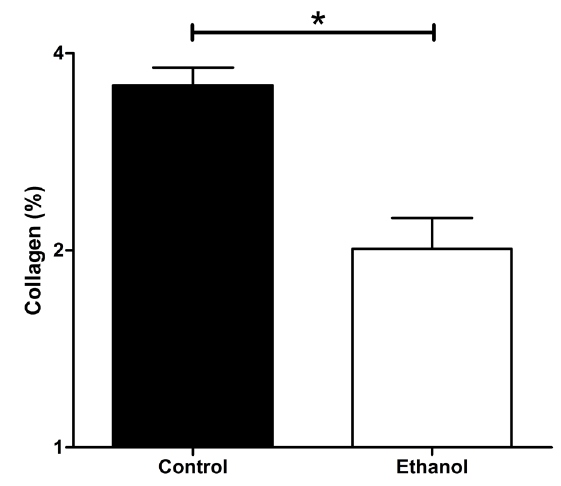
Figure 5. Percentage of collagen in the proximal metaphysis of the femoral neck in the control group and in the alcohol group. Mann Whitney test; *asterisk indicates significant difference